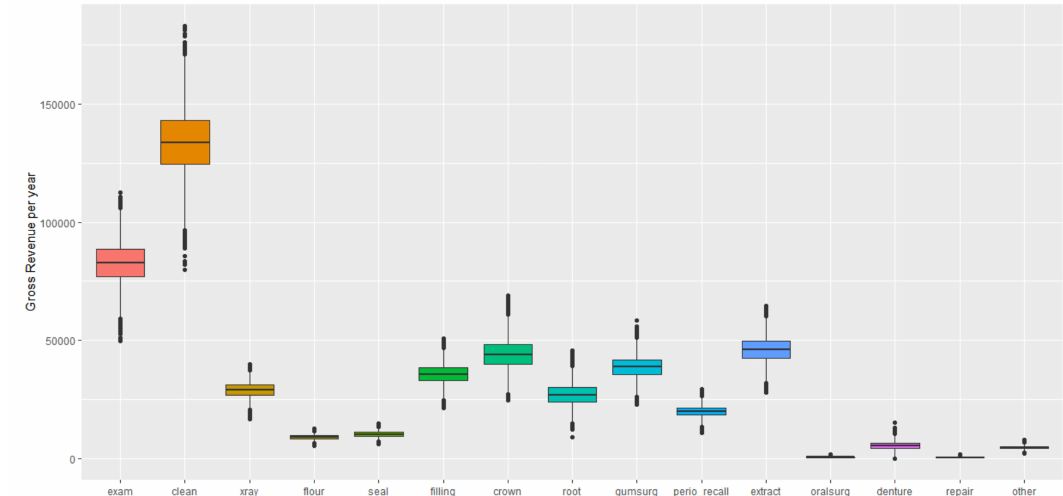
Figure 2. Gross revenue by procedure type, showing the minimum (lower whisker), maximum (upper whisker), median (center of the box), lower quartile (bottom of box), and upper quartile (top of box) values. Exam = diagnostic; clean: prophylaxis; X-ray = radiographic image; flour = fluoride; seal = sealant; root = root canal; gumsurg = periodontal scaling, root planning or gum; extract